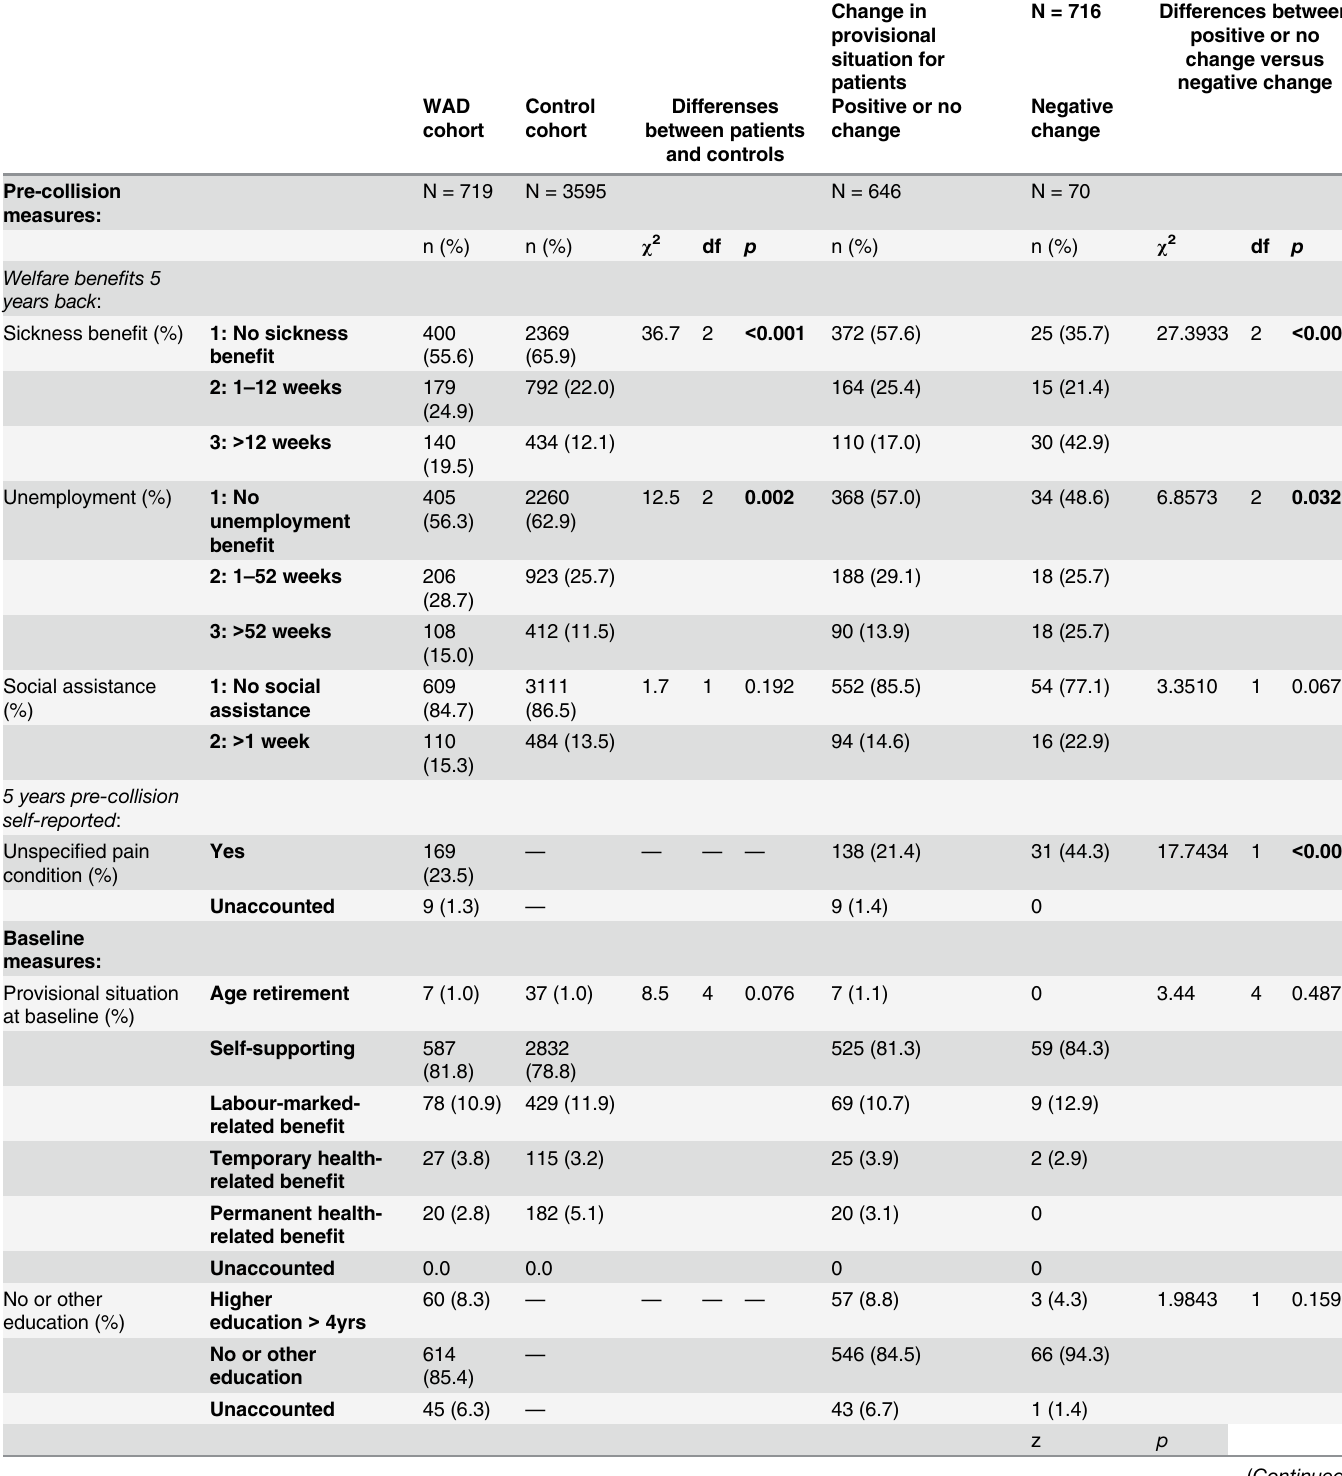
Table 4. Characteristics of WAD and control cohorts, and WAD cohort split into positive or no change versus negative change in provisional situation.